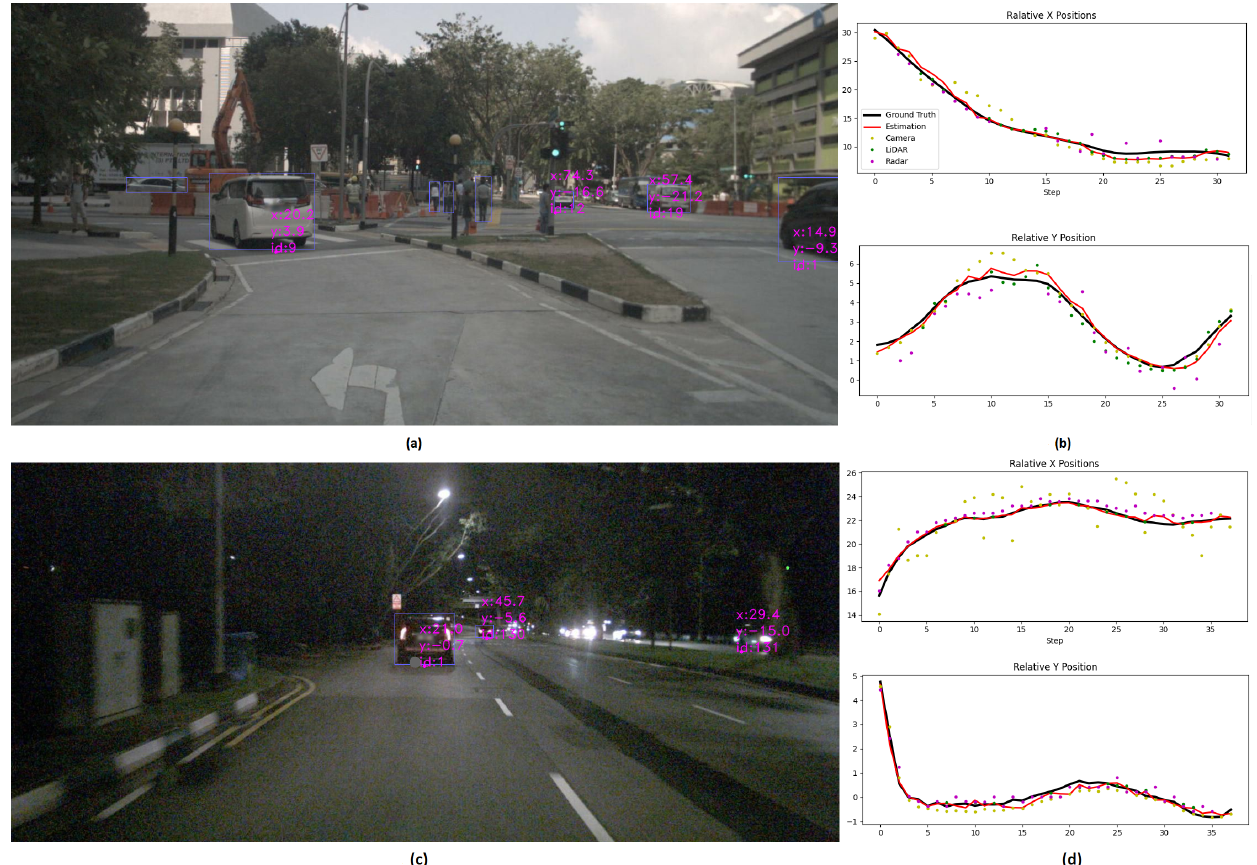
Figure 6. ( a , c ) Front camera view of nuScenes dataset, where x (longitudinal) and y (lateral) are relative distances from the ego car position. (Positional information text was removed from persons for better readability.) ( b ) Frame-by-frame comparison between tracking results and ground truth for the white van seen in the image. ( d ) Frame-by-frame comparison between tracking results and ground truth for red sedan seen in the